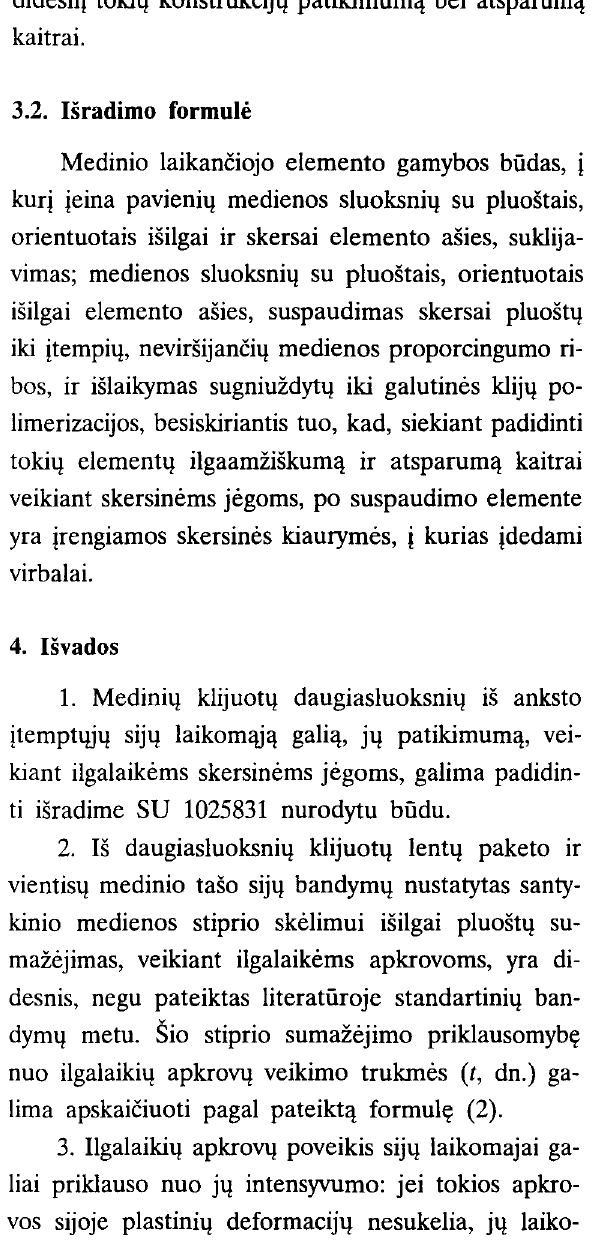
Fig 6. The manufacture scheme of multilayered prestressed element described in the invention SU 1025831 before (a) and after(b) gluing together and fitting in the pivots: 1 - longitudinal timber layers; 2 - lateral layer of timber or plywood; 3 - pivot; 4 - vertical prestresses cry ; 5 -